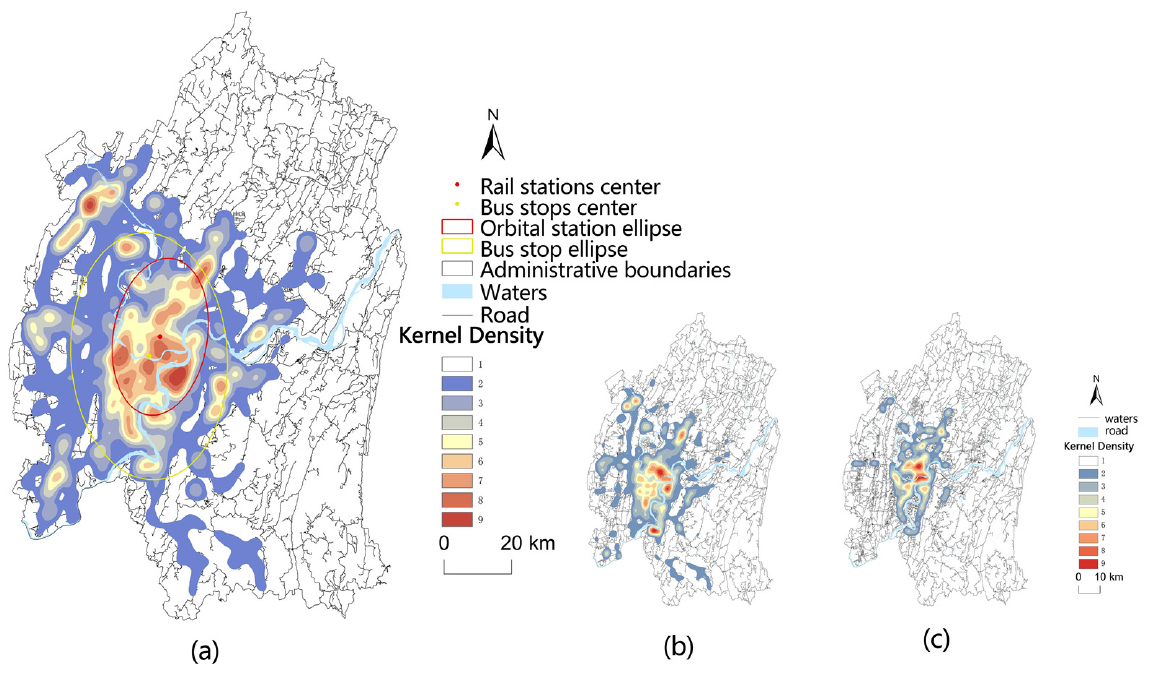
Figure 4. Kernel density analysis chart of public transport stations: ( a ) general public transport stations; ( b ) bus stops; ( c ) rail station.